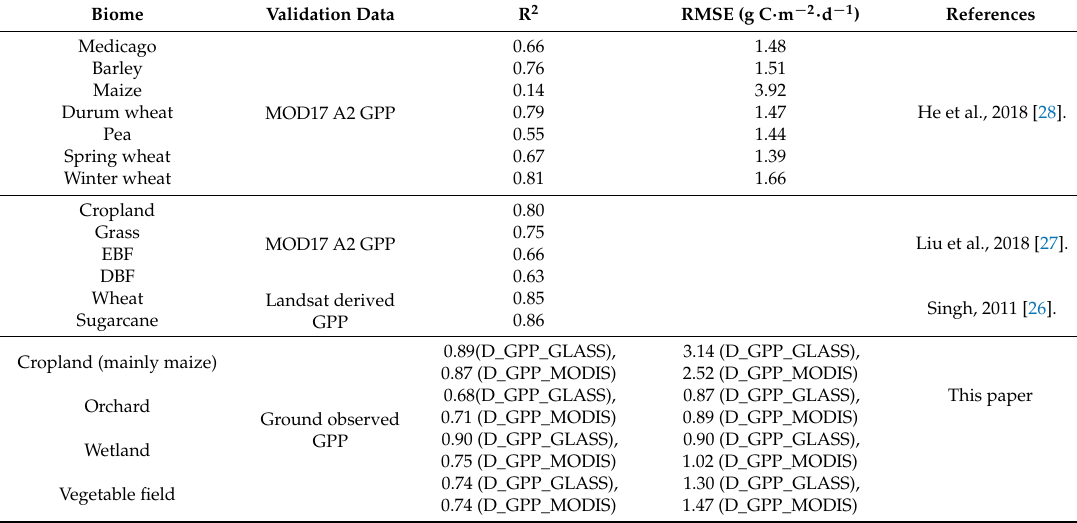
Table 2. Comparison of the GPP estimates from spatial and temporal adaptive reflectance fusion model